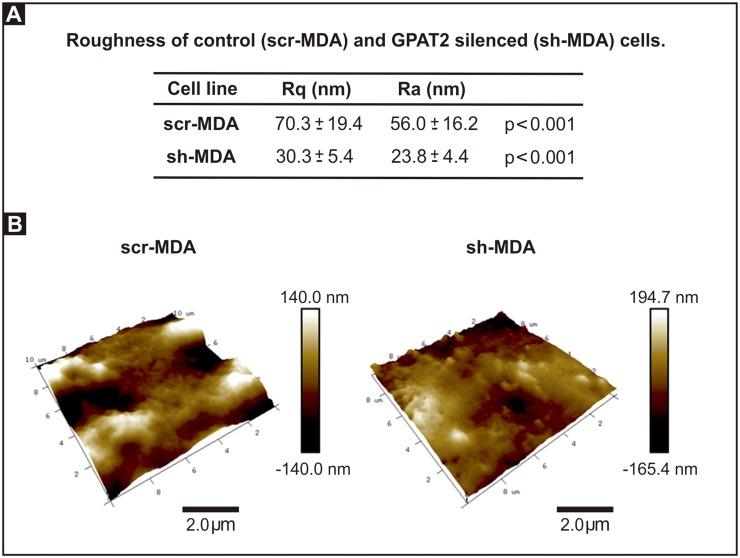
Cells sub-expressing GPAT2 exhibit smoother topography.A) Ra and Rq values of scr-MDA and sh-MDA cells. B) 3D AFM topography images of scr-MDA and sh-MDA cells at 10.0 μm x 10.0 μm showing cell surface details.